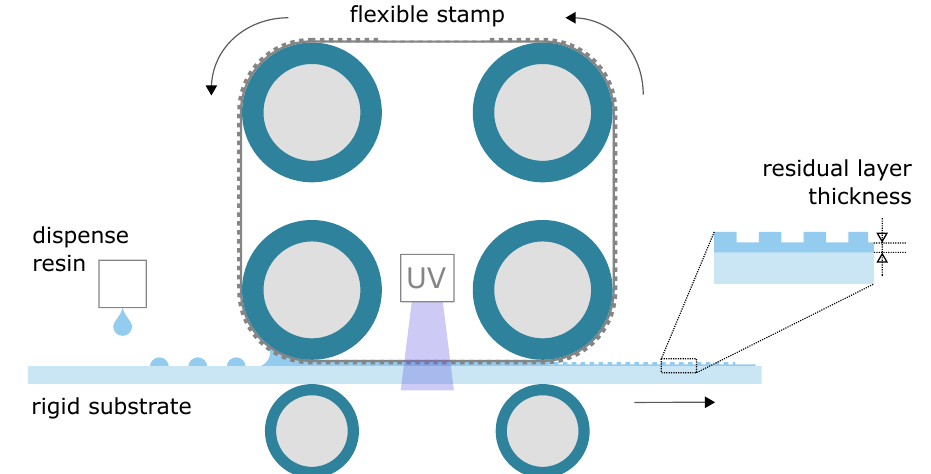
Figure 1. Schematic of a roll-to-plate imprint system. Picture is adapted from [20]. Previous work on the simulation of the RLT and its uniformity is given for plate-to- plate imprint systems [21–24]. For roller-based imprint systems, analytical expressions for the RLT [25] and droplet merging under the imprint roller [18] are presented. The elastic deformation of the roller material is not taken into account. It is included by Taylor [26], who developed a contact mechanics-based model to simulate the RLT. The rollers in roller- based imprint systems are typically equipped with a relatively soft, elastomeric layer, which elastically deforms during the imprint process, due to the hydrodynamic pressure build-up in the resin film. The elastic deformation is relatively large compared to the film height, and affects the hydrodynamic pressure profile in the resin film, in return. The result is a strong coupling between the hydrodynamic and elastic effects, which is described by elastohydrodynamic lubrication (EHL) theory. The working principle behind roller-based imprint systems is analogous to roller-based coating and printing processes [27–30]. These studies also use EHL theory for the prediction of the coating or printing layer height. When the thickness of the elastomeric layer is relatively small, it influences the elastic deformation and its finite thickness needs to be taken into account [28,31–33]. Cochrane also employs EHL theory to predict the RLT in a roll-to-roll set-up to imprint deformable substrates [34]. Lubrication theory is combined with the inextensible cylindrical shell theory to couple the pressure build-up in the thin film of resin with the motion and elastic forces of the deformable